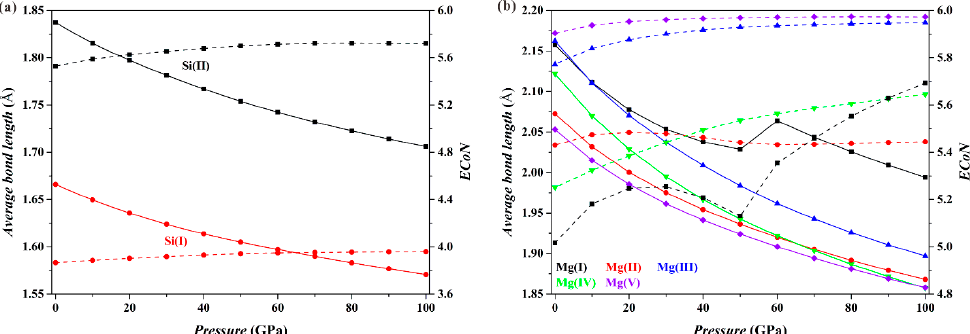
Figure 3. Evolution of the average bond length ( d mean ) and ECoN parameters of the polyhedra of the Fo-II phase as pressure increases from 0 to 100 GPa (0 K): ( a ) the [Si(I)O 4 ] and [Si(II)O 6 ] polyhedra; ( b ) the Mg-O polyhedra. For the information about the Si(I) and Si(II), and the Mg(I), Mg(II), Mg(III), Mg(IV) and Mg(V), see Supplementary Tables S2 and